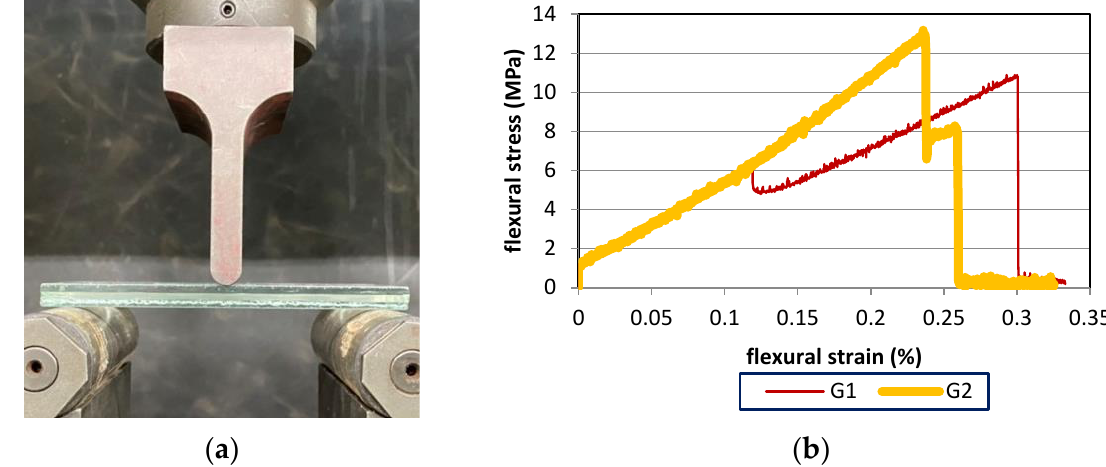
Figure 4. Three-point bending test of laminated glass: ( a ) performed test and ( b ) stress-strain relations.